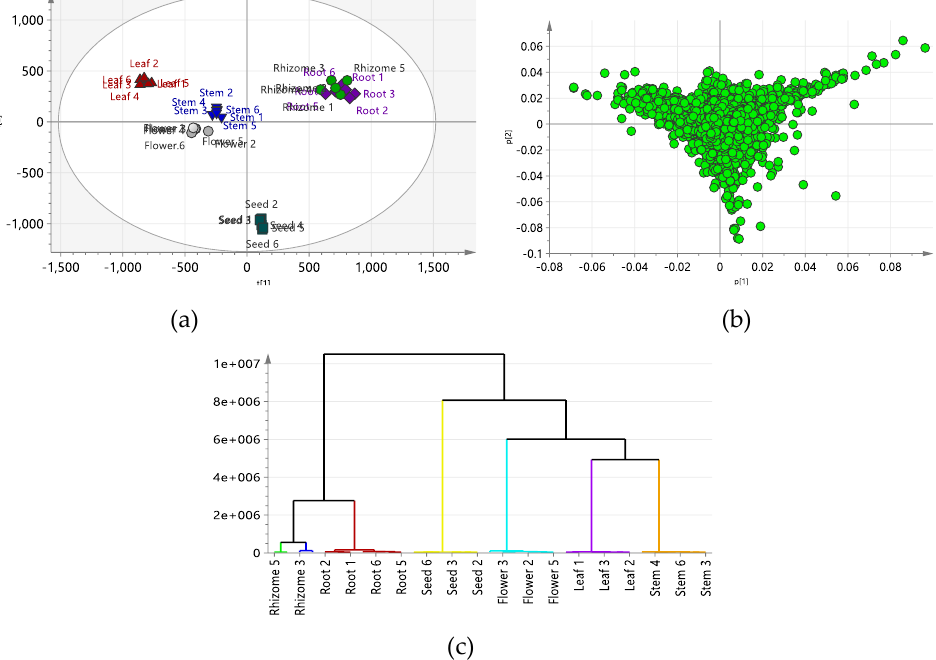
Figure 1. Principal component snalysis (PCA) and hierarchical cluster analysis on root, rhizome, leaf, flower, stem and seed groups. ( a ) Scores plot, ( b ) Loading plot, ( c ) Hierarchical cluster analysis of all samples. PCA and Hierarchical cluster analysis using all of the 4309 ion signals. Scores plot and loading plot of PCA model gives 2D visual information about the variations among different groups. Unsupervised PCA score plots showing the discrimination of samples. R 2 = 0.741, Q 2 = 0.621.